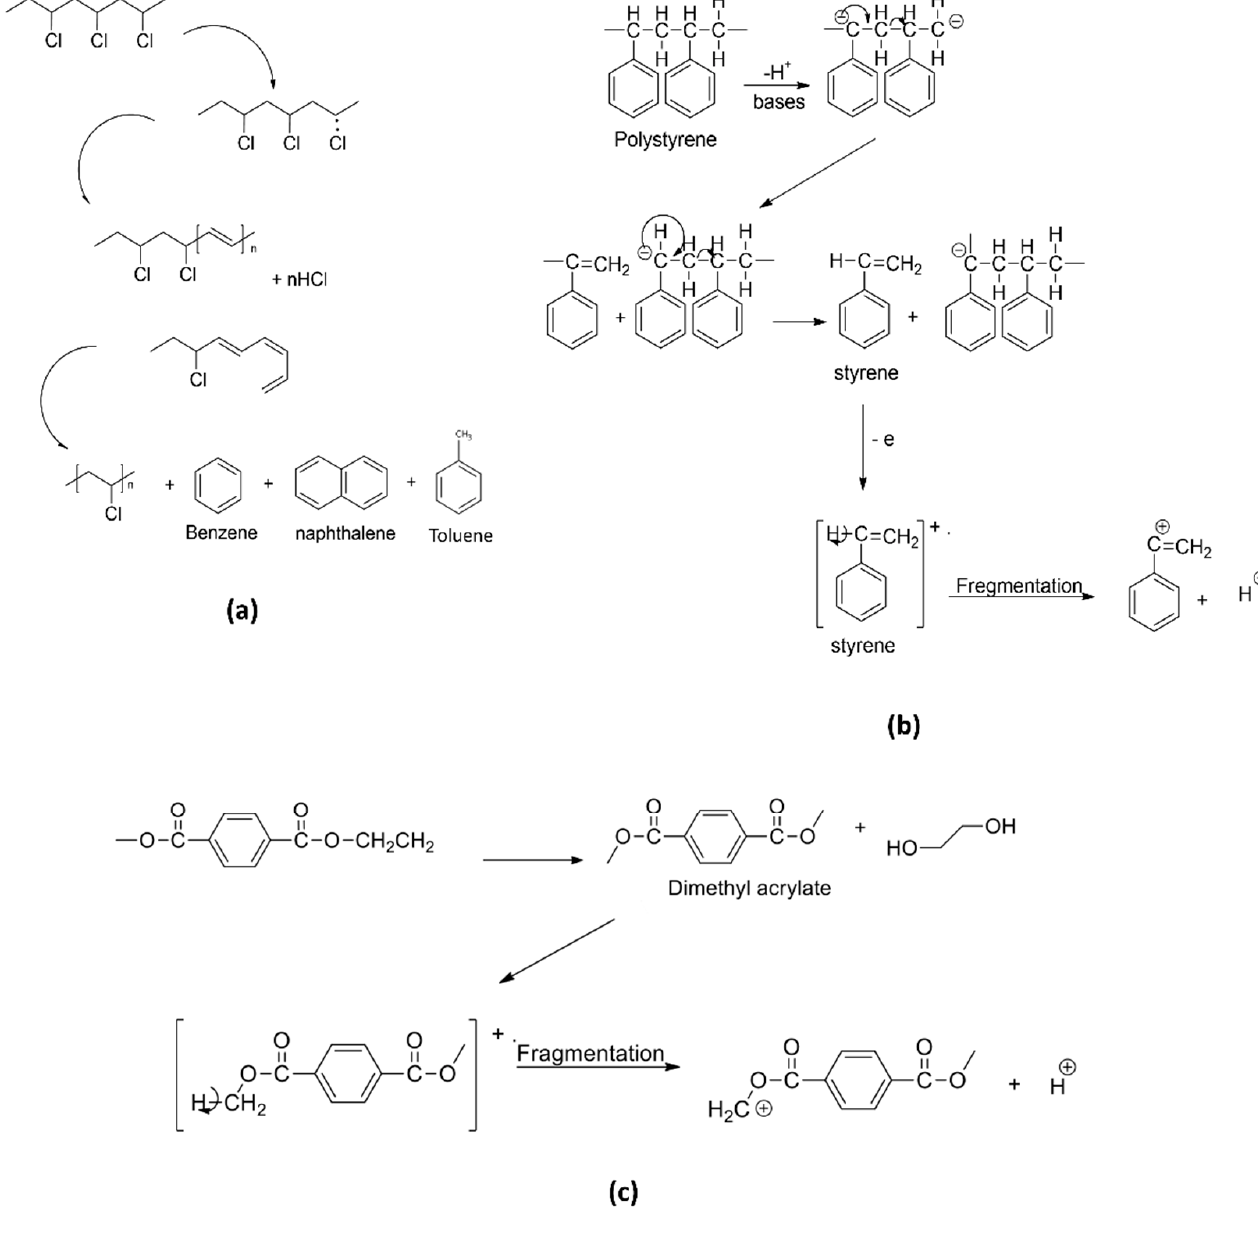
Figure 4. Simplification of degradation mechanism of common polymers into respective monomers: ( a ) PVC, ( b ) PS, and ( c )